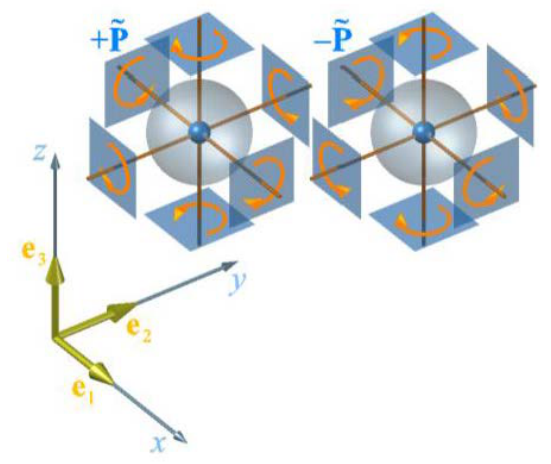
Figure 23: Relationship between outer orientation of a point and inner orientation of a